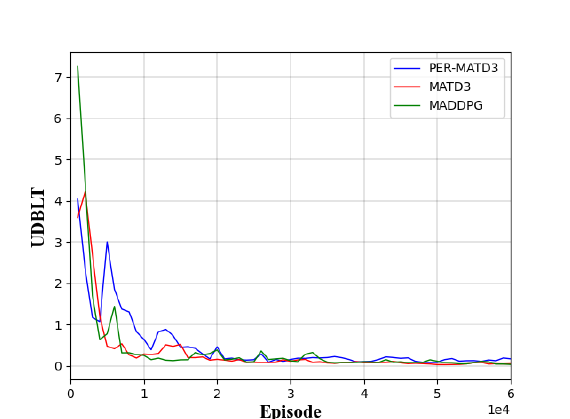
Figure 8. Final distance of the leader robot from the target point (UDBLT).